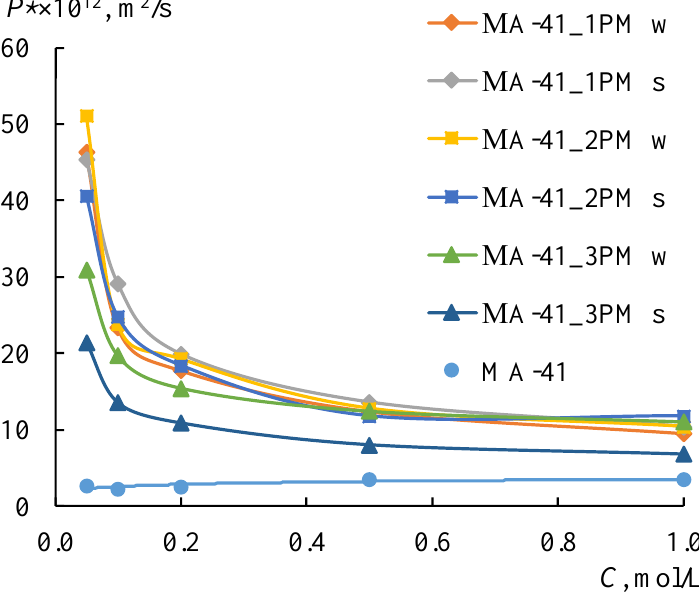
Figure 9. Concentration dependencies of the diffusion permeability of the initial MA-41 membrane and profiled bilayer membranes.